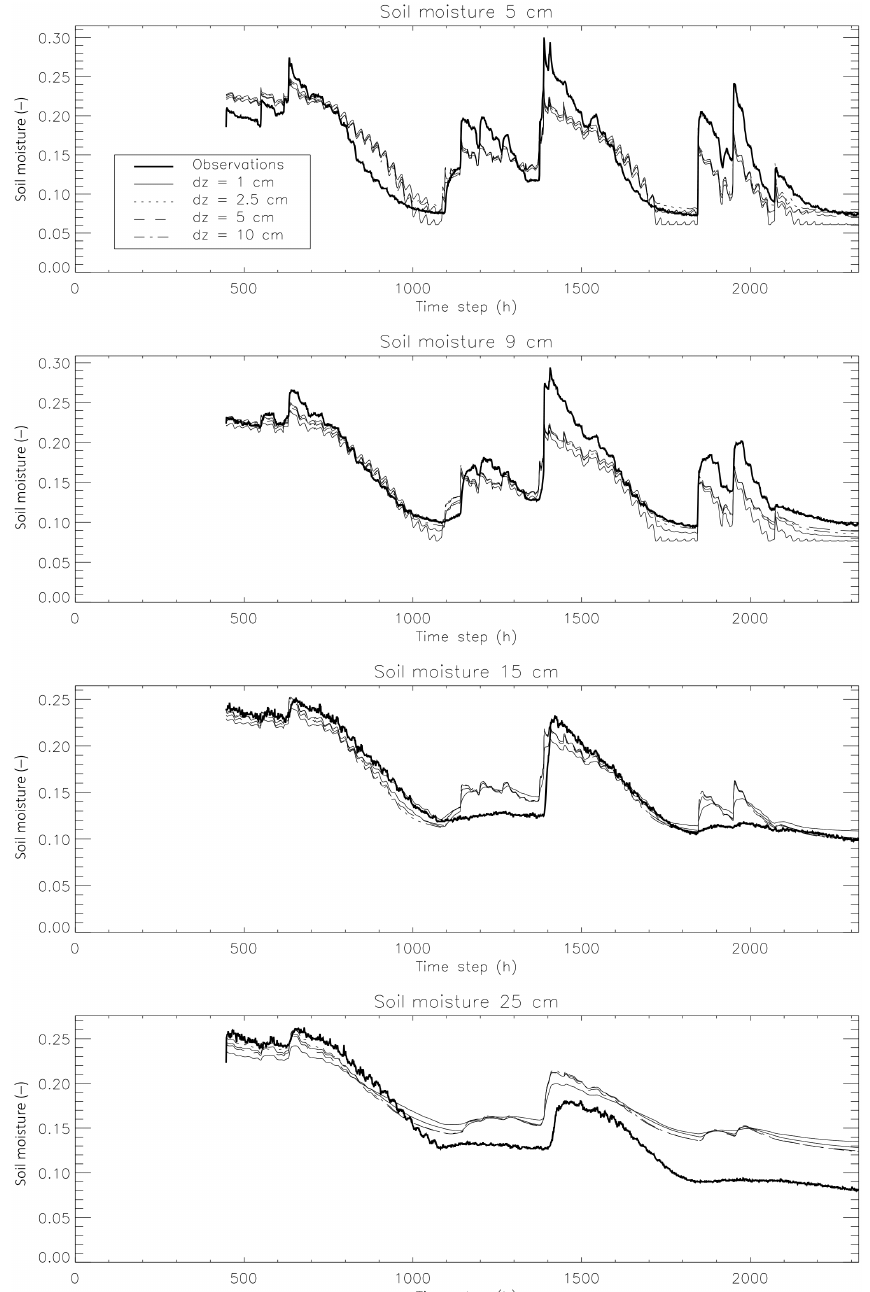
Figure 7. Comparison between the modeled and the observed soil moisture values for the four different spatial resolutions, and an analytical solution of the heat conduction